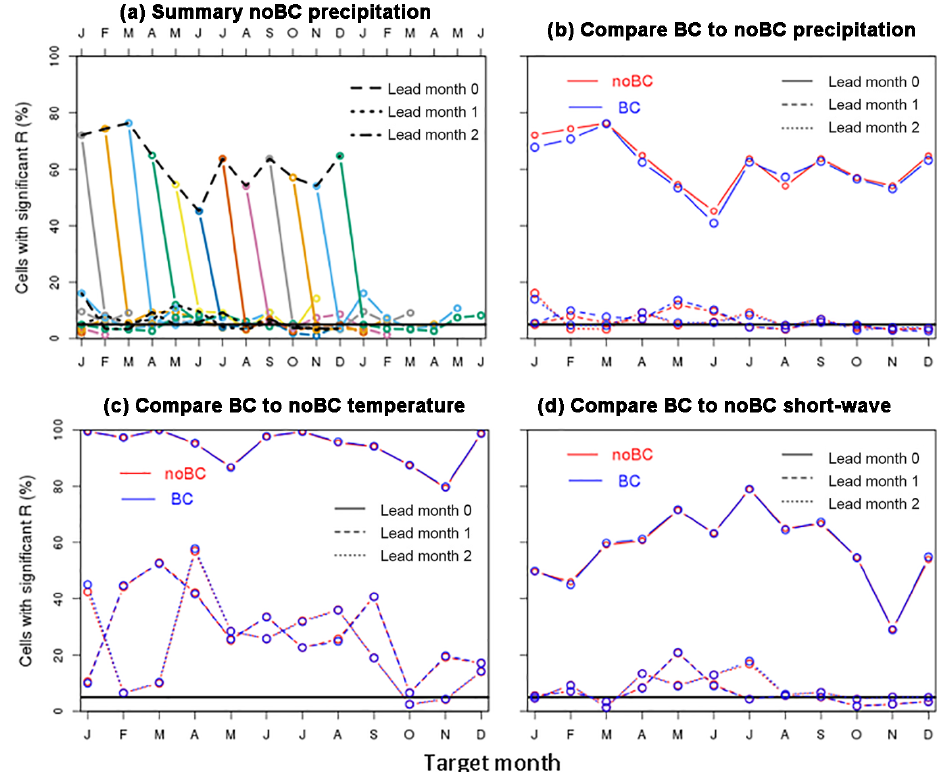
Figure B1. Skill, in terms of the percentage of cells with significant values of R , for three components of the raw S4 forcing. (a) shows precipitation skill as a function of target and lead month. The other three panels compare the skill of the raw S4 output (noBC), with its bias-corrected version (BC) as a function of the target month for the first 3 lead months. Precipitation is plotted in (b) , temperature in (c) and incoming short-wave radiation in (d)